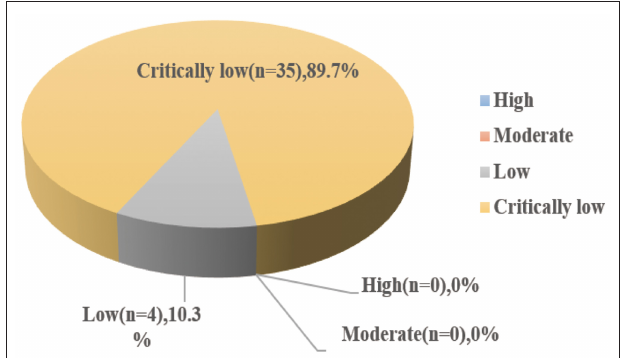
FIGURE 2 | Map of results of AMSTAR 2.